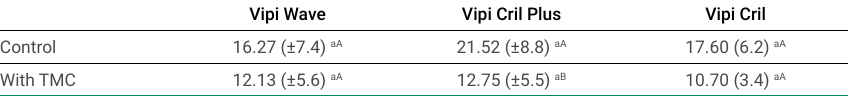
Table 2. Comparison of bond strength mean values (MPa) (± standard deviations) of artificial teeth to denture base resins as a function of the thermomechanical cycling (TMC) Vipi Wave Vipi Cril Plus